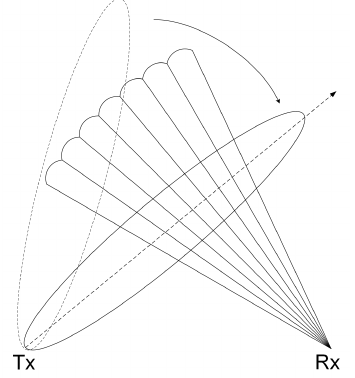
Figure 5. Sketch map of simultaneously